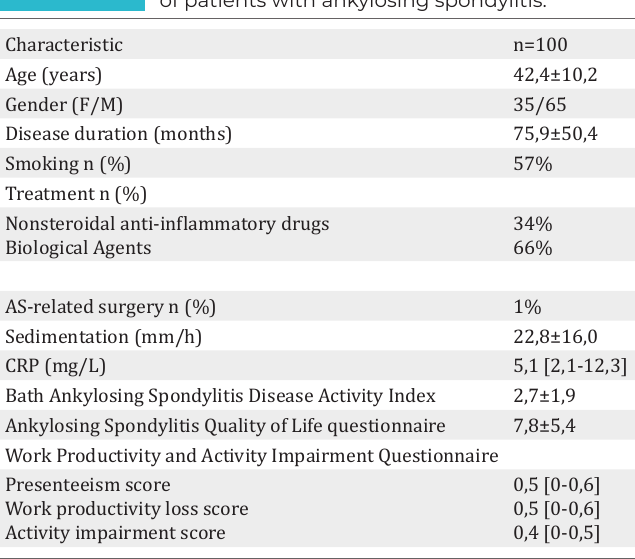
Demographic, clinical and laboratory features of patients with ankylosing spondylitis.